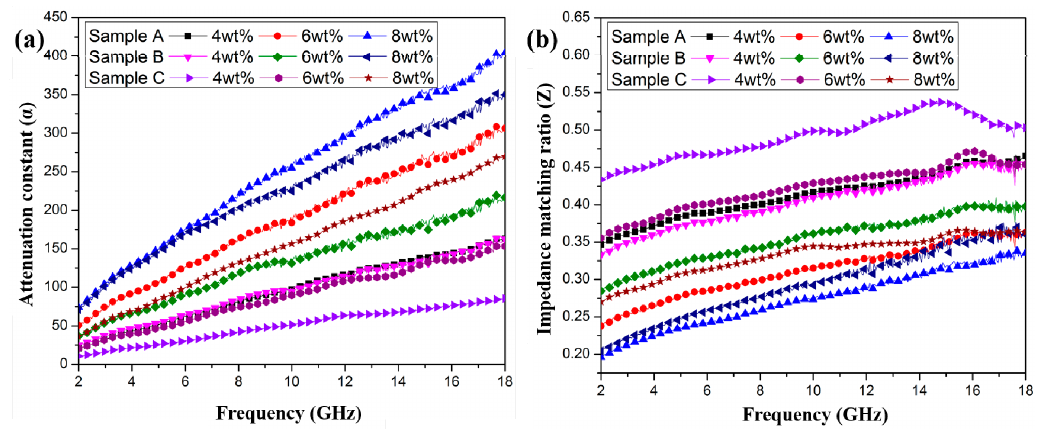
Figure 6. Frequency dependence of the attenuation constant ( a ) and impedance matching ratio ( b ) of samples A, B, and C with different filler loading ratios.